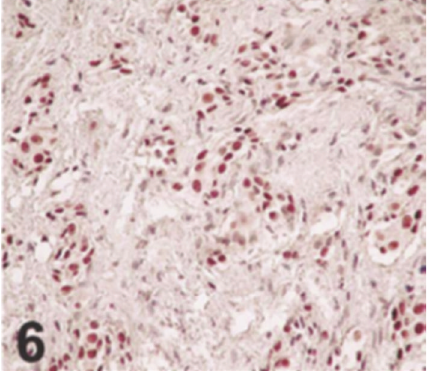
Figure 10: The neoplastic cells are strongly immunoreactive for p63 (Case 2) (p63, original magnification × 400) Xiao et al.